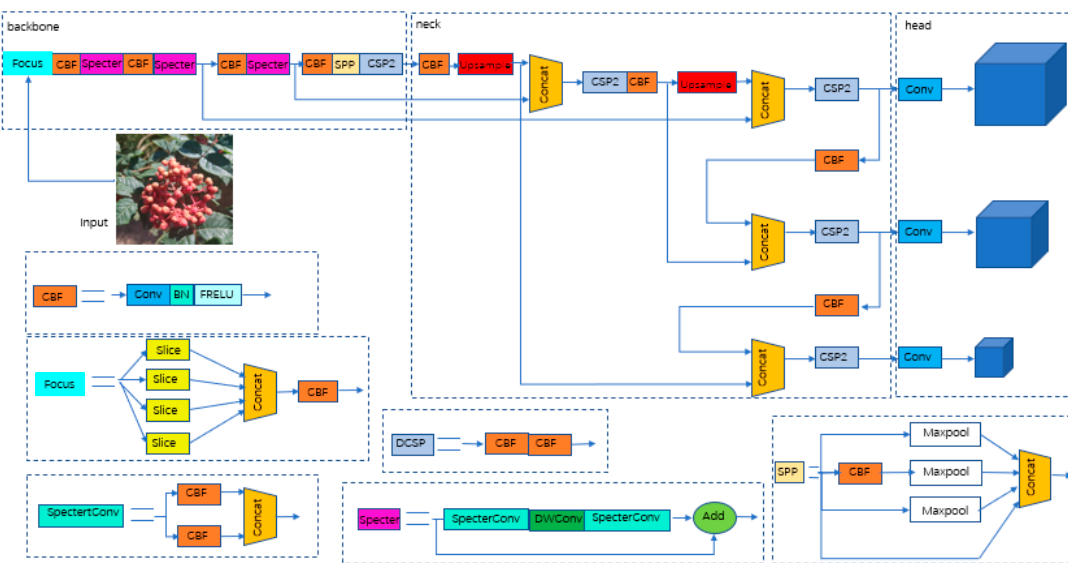
Figure 7. Improved YOLOv5 network.